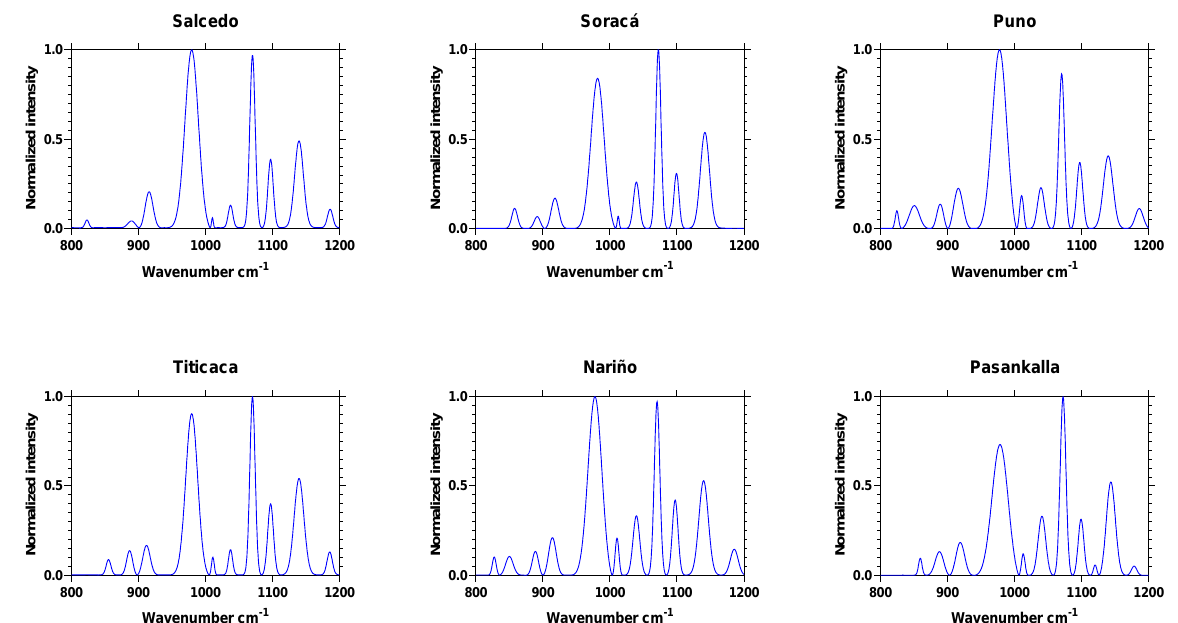
Figure 5. Deconvolution of the starch FTIR band in six Colombian quinoa grain cultivars.